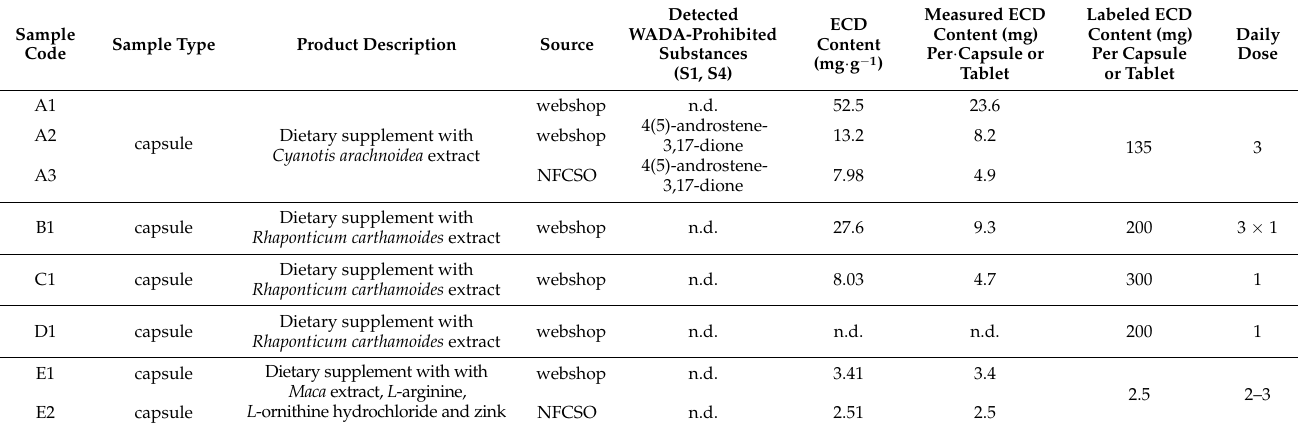
Table 3. Detailed list of analysed products, including name sample type, description, lot number, source, daily dose, labeled ECD content, and results. Each product was encoded with an uppercase letter from “A” to “J”. In addition, consecutive numbers were assigned to different batches. In the case of product “H”, there were daily packs, containing 4 different types of capsules and